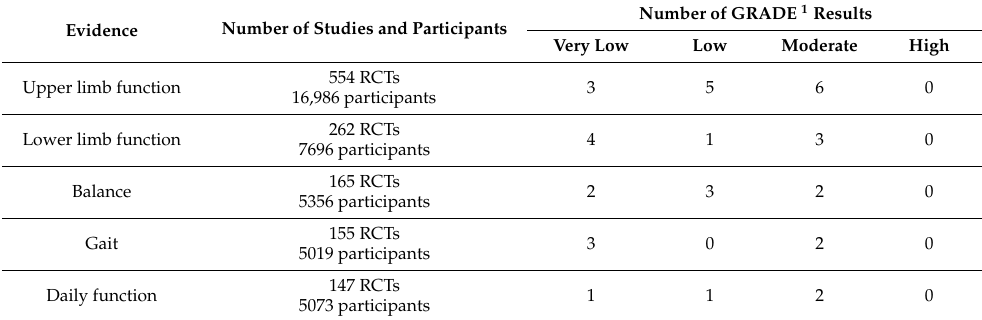
Table 5. Synthesis of the best evidence (n =